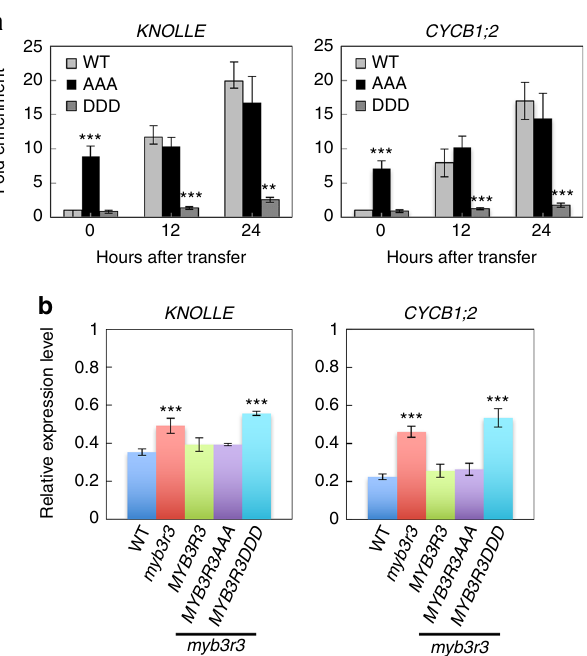
Fig. 8 Non-phosphorylated form of MYB3R3 represses the KNOLLE and CYCB1;2 promoters. a ChIP-PCR analysis of KNOLLE and CYCB1;2 . Ten-day- old seedlings of myb3r3 carrying ProMYB3R3::MYB3R3-GFP (WT), ProMYB3R3::MYB3R3AAA-GFP (AAA) or ProMYB3R3::MYB3R3DDD-GFP (DDD) were treated with 2 μ M zeocin for the indicated times, and used for ChIP assay. Chromatin bound to MYB3R3 was collected by immunoprecipitation with anti-GFP antibodies. Fold enrichment of each promoter region was determined by normalizing the recovery rate against that of ProMYB3R3 :: MYB3R3 - GFP without zeocin treatment. Data are presented as mean ± SD of three biological replicates. Signi fi